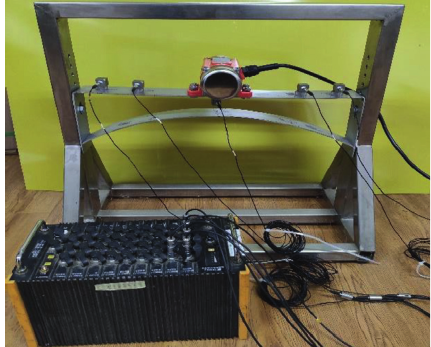
Figure 25: Experimental signal acquisition system site.